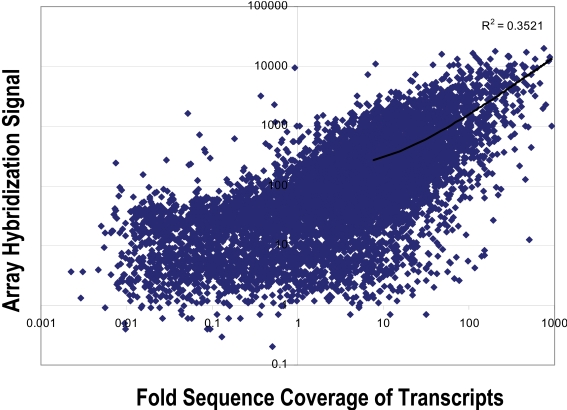
Comparison of gene expression levels measured by two methods.Comparison of gene expression levels detected by average shotgun, mRNA SBS coverage per transcript (normalized for transcript length) versus Affymetrix oligonucleotide microarray hybridization for cerebellar cortex sample #41 (38.7 million reads). Microarray images were scaled to an average hybridization intensity of 200, and the threshold for expression was an average hybridization intensity of ≥50.